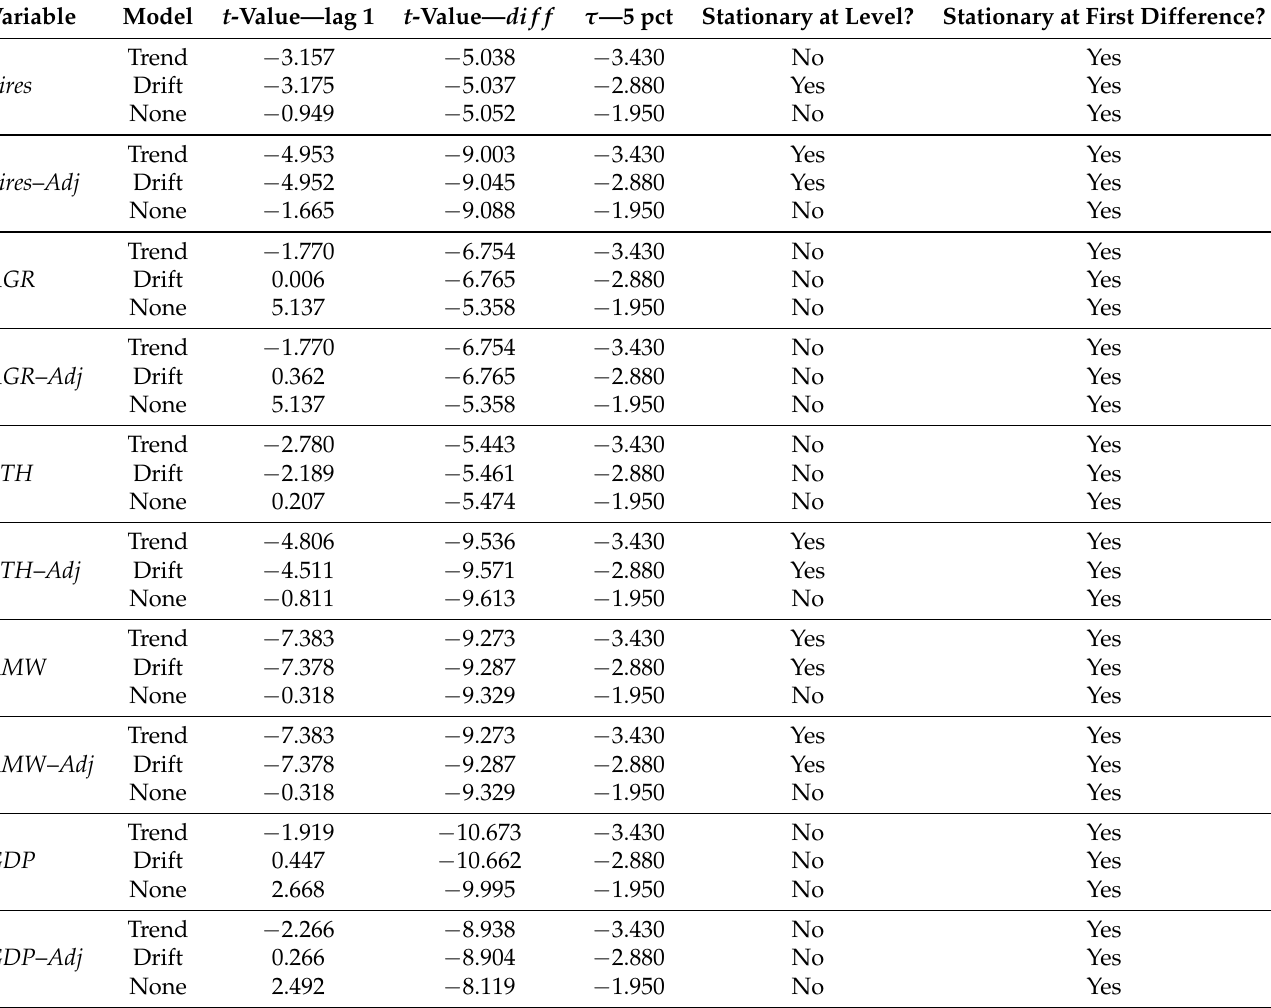
Table 2. The ADF unit root test for the variables. Significance level of 95% ( t -value < τ − 5 pct) rejects the null hypothesis of